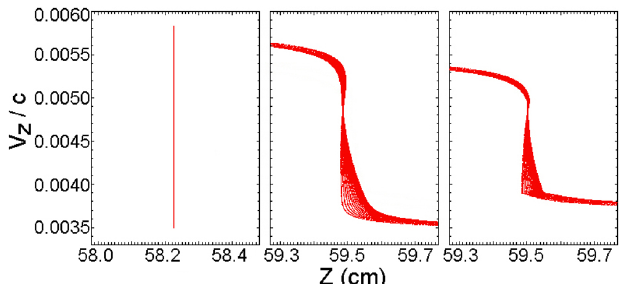
g phase space at the focal plane for the FIG. 5. (Color) f z; v z T k (cid:4) 0 eV beam using the sharp waveform across an infinitely thin gap (left), and smooth (center) and sharp (right) waveforms across the finite-size gap. Longitudinal focus occurs at z (cid:4) (cid:8) 58 : 25 cm and t (cid:4) 950 ns for the former case, and at z (cid:4) (cid:8) 59 : 5 cm and t (cid:4) 959 ns for the latter